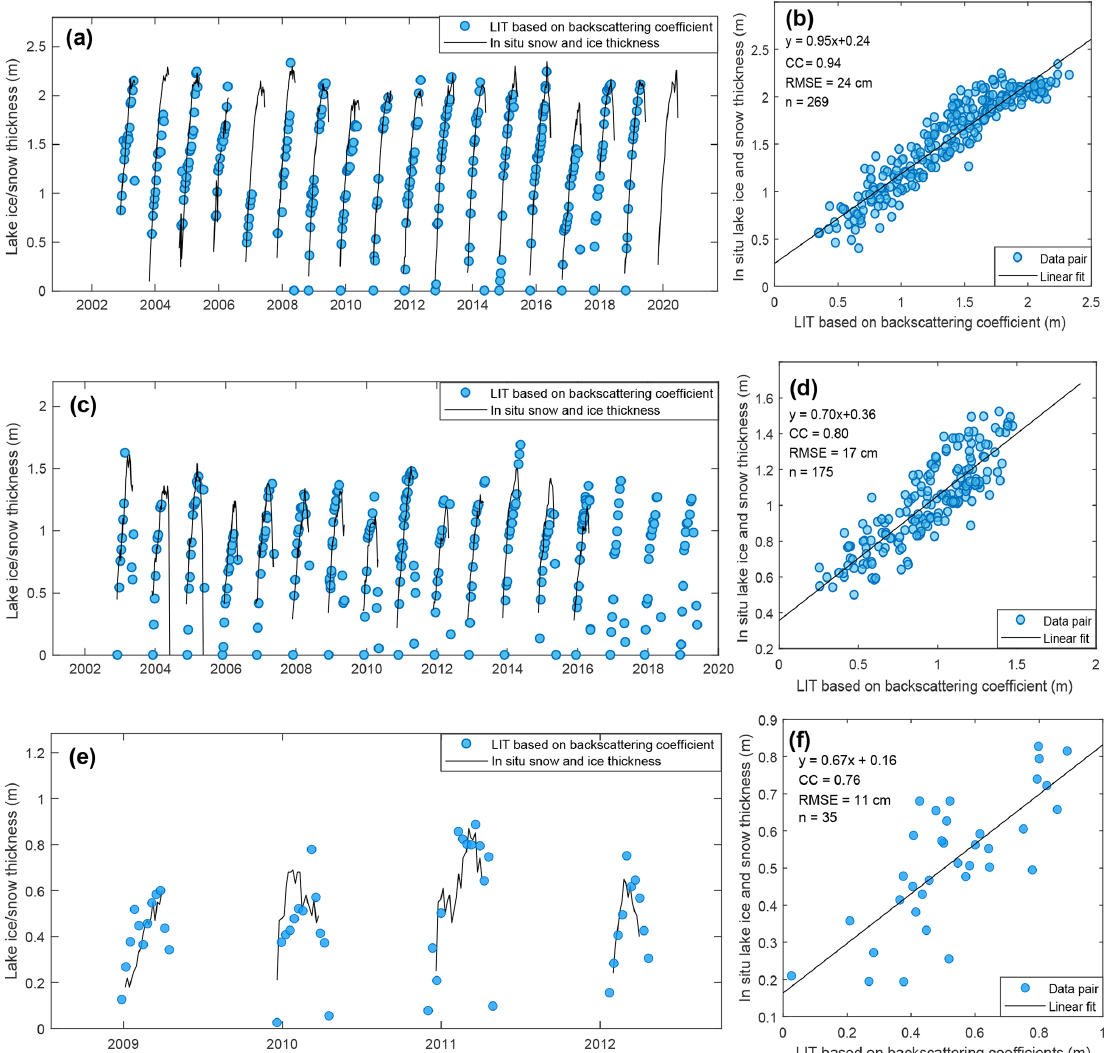
Figure 7. Validation of backscattering-coefficient-based LIT against the total thickness of ice and snow. Panels (a) , (c) , and (e) are time series for the backscattering-coefficient-based LIT and the in situ lake ice and snow thickness in Baker Lake, GSL, and Peipus Lake. Panels (b) , (d) , and (f) are the scatterplots of backscattering-coefficient-based LITs and in situ lake ice and snow thickness in Baker Lake, GSL, and Peipus Lake,